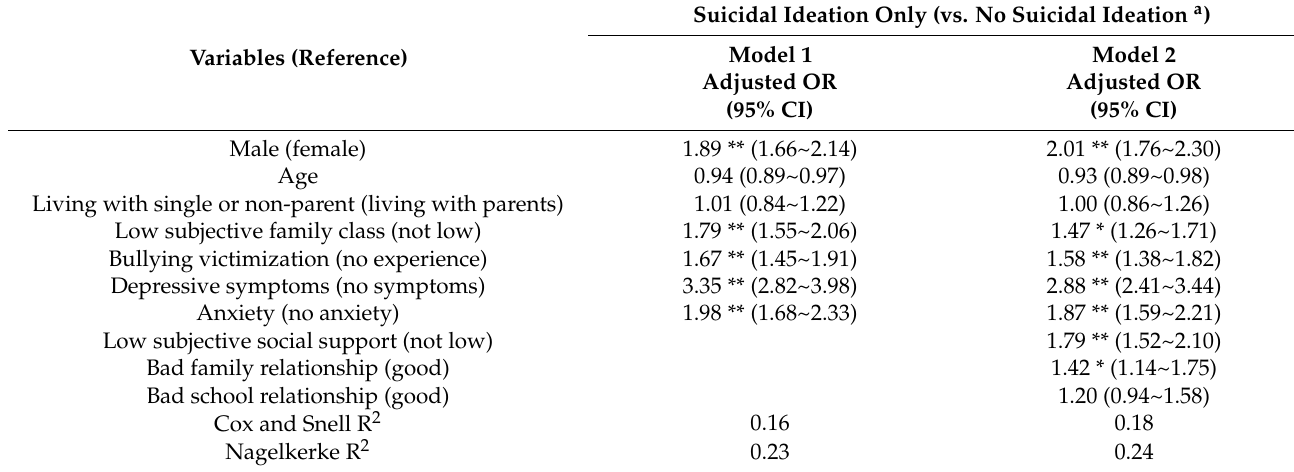
Table 2. Factors associated with suicidal ideation.